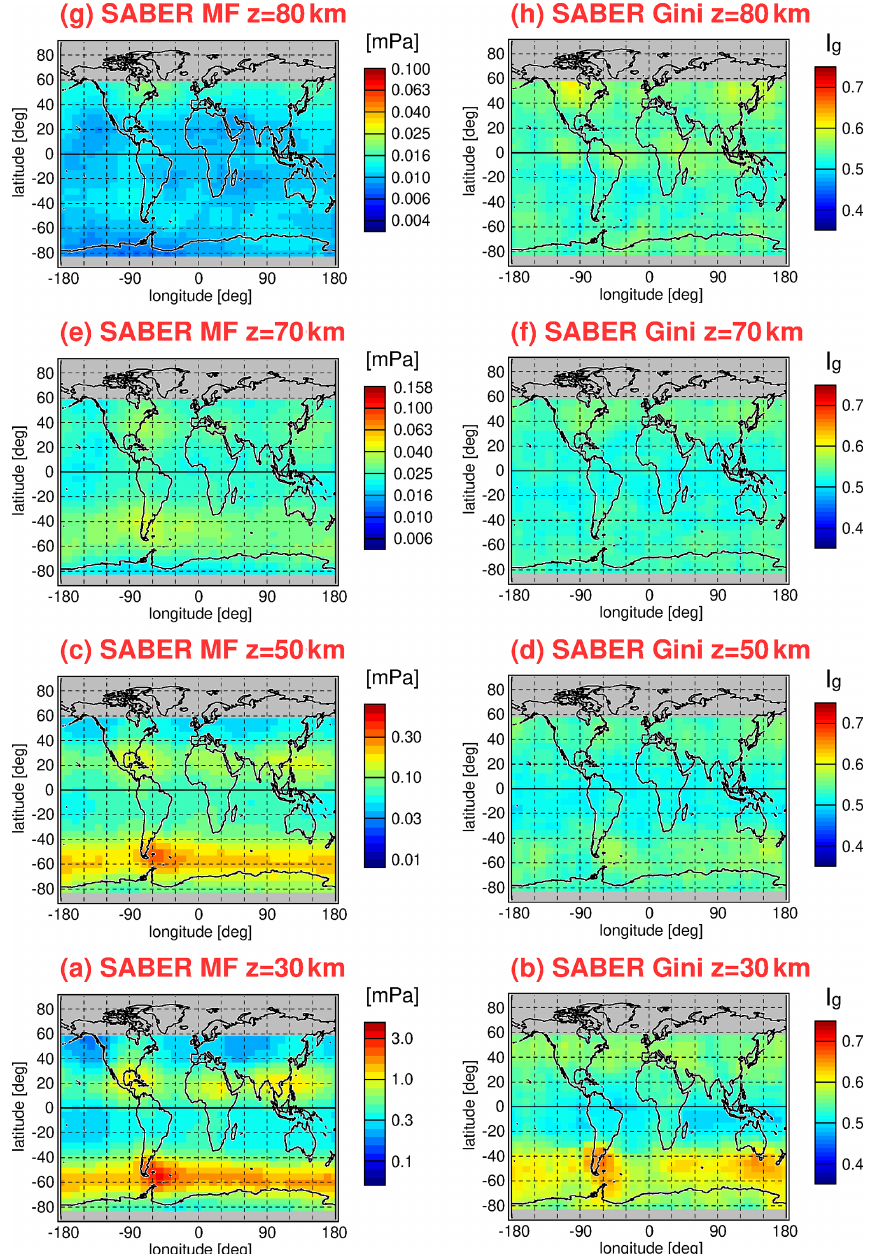
Figure 17. Global distributions of (a, c, e, g) SABER median absolute gravity wave momentum fluxes (MF) at altitudes of 30, 50, 70, and 80km for the calendar month of August as well as (b, d, f, h) the corresponding global distributions of Gini coefficients. Again, the global distributions are arithmetic means obtained over the period from January 2002 to October